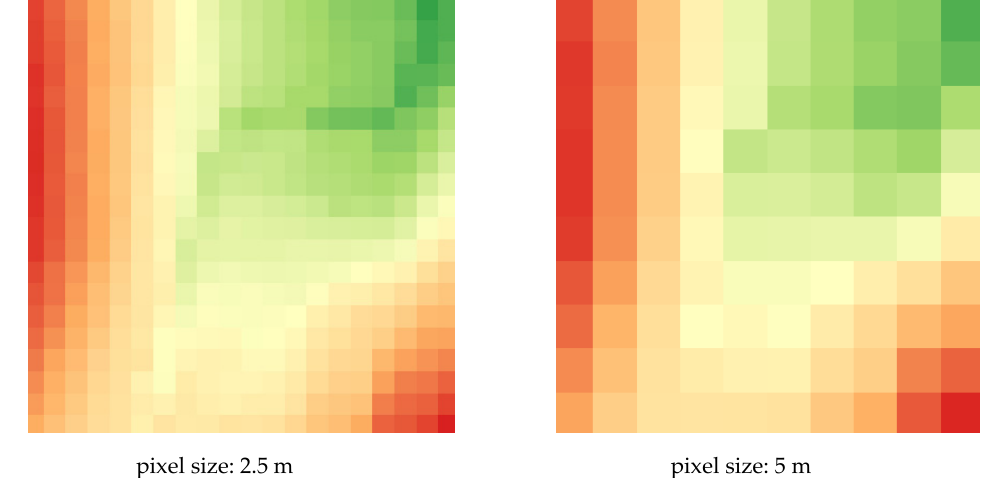
Figure 3. Used DEMs with different pixel sizes on examples of concave terrain.